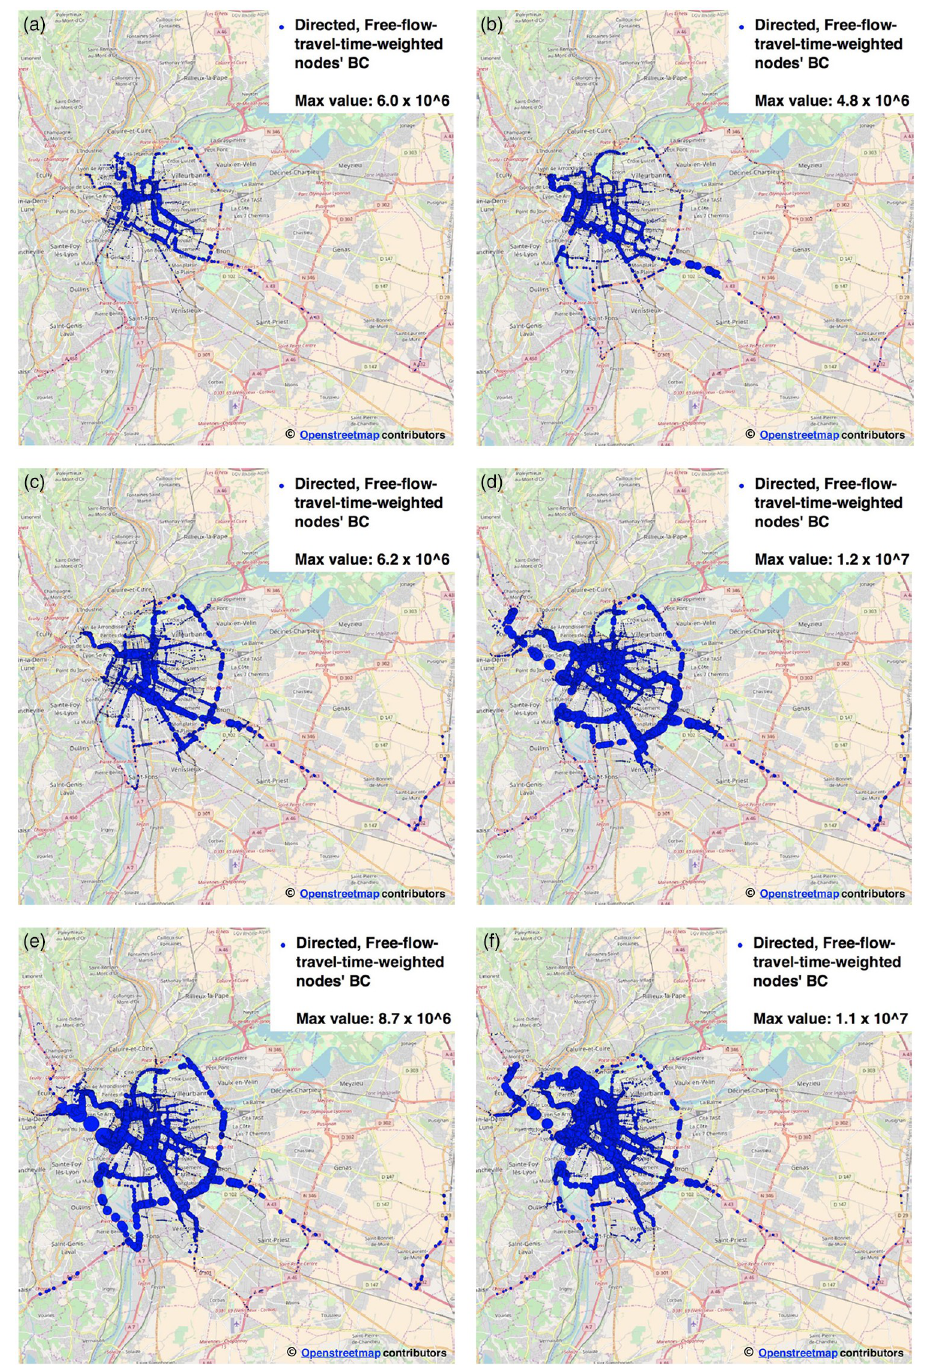
Fig 5. Nodes’ travel-time-weighted BC over the dynamic graph in the time range [05:00–10:00]. The size of each circle in the subplots is proportional to node’s BC. (a) 06:00 (b) 07:00 (c) 08:00 (d) 09:00 (e) 10:00 (f) 11:00. number of the weighted shortest paths. Similarly, some specific arterials traversing the city center also appear as associated with higher TTBC. It is worth noting that such critical roads change frequently, depending on the specific time slot, thus unveiling high traffic dynamics at morning peak hours.